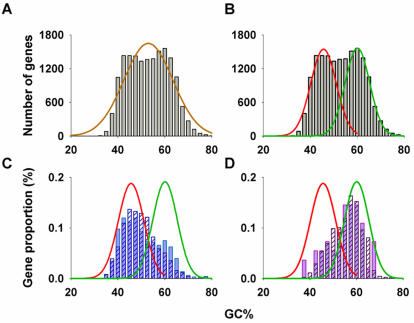
Distribution of coding GC% of RefGenes with PCIs.Unimodal (A) and bimodal distribution curves (B) were fitted to coding GC% distribution. C, Coding GC% of paralogs of processed pseudogenes with (light blue filled) and without PCIs (open blue stroke) shift towards lower GC content. D, Coding GC% of housekeeping genes with (purple fill) and without PCIs (purple stroke) shift towards higher GC. See Methods for subset derivation.